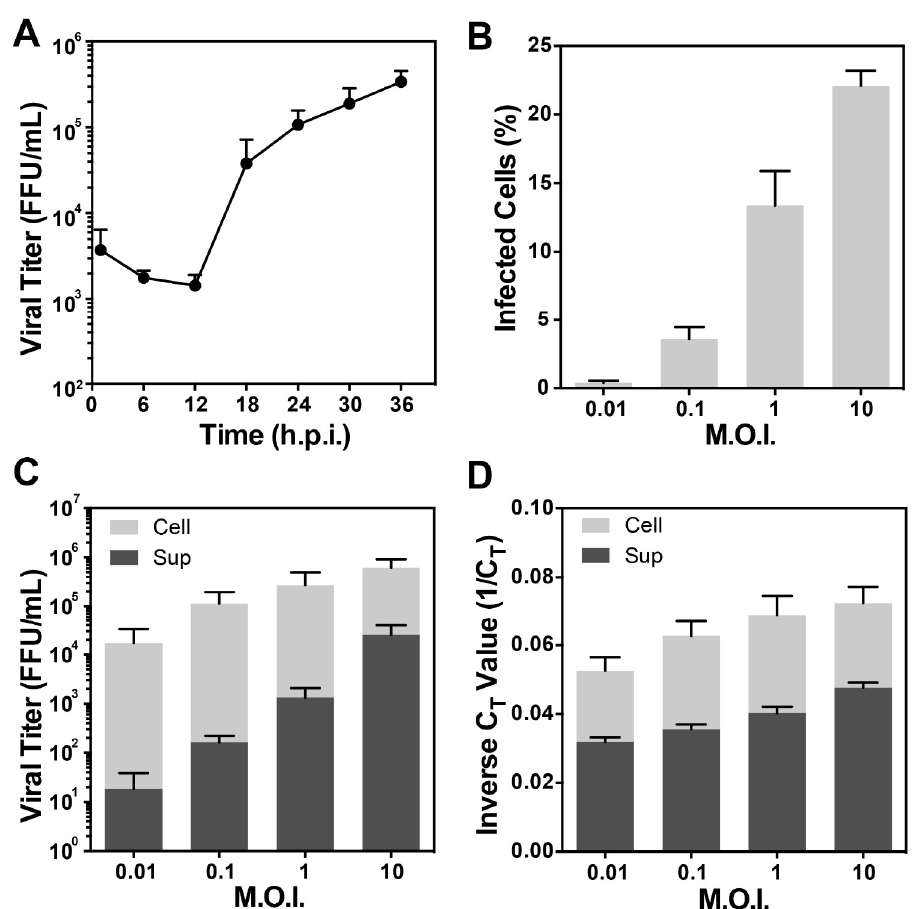
Figure 1. Assessment of sample preparation conditions for cryo-EM data collection. ( A ) One-step growth curve of RSV A2 in BEAS-2B cells over a period of 36 h at a M.O.I. of 10. Infected cells were harvested at indicated time points and titrated in Vero cells. ( B – D ) Flow cytometry, viral titer, and RNA quantification analysis of RSV-infected BEAS-2B cells, at indicated M.O.I.s after 24 h.p.i. These data indicate that at a M.O.I. of 10, infectious particles are produced at 24 h.p.i., suggesting that the particles being imaged by cryo-EM are infectious. ( B ) Relative ratio of cells infected at indicated M.O.I. by flow cytometry using mK + signal, represented by the ratio of infected cells over the total cells. ( C ) Viral titer at 24 h.p.i. determined by FFU using mK + signal. ( D ) Relative amount of viral RNA from infected cells determined by real time RT-PCR represented by inverse C T values (1/C T ). C T value is the number of cycles needed to pass the background level. For all 4 experiments, error bars represent the standard deviation of 3 independent experiments.